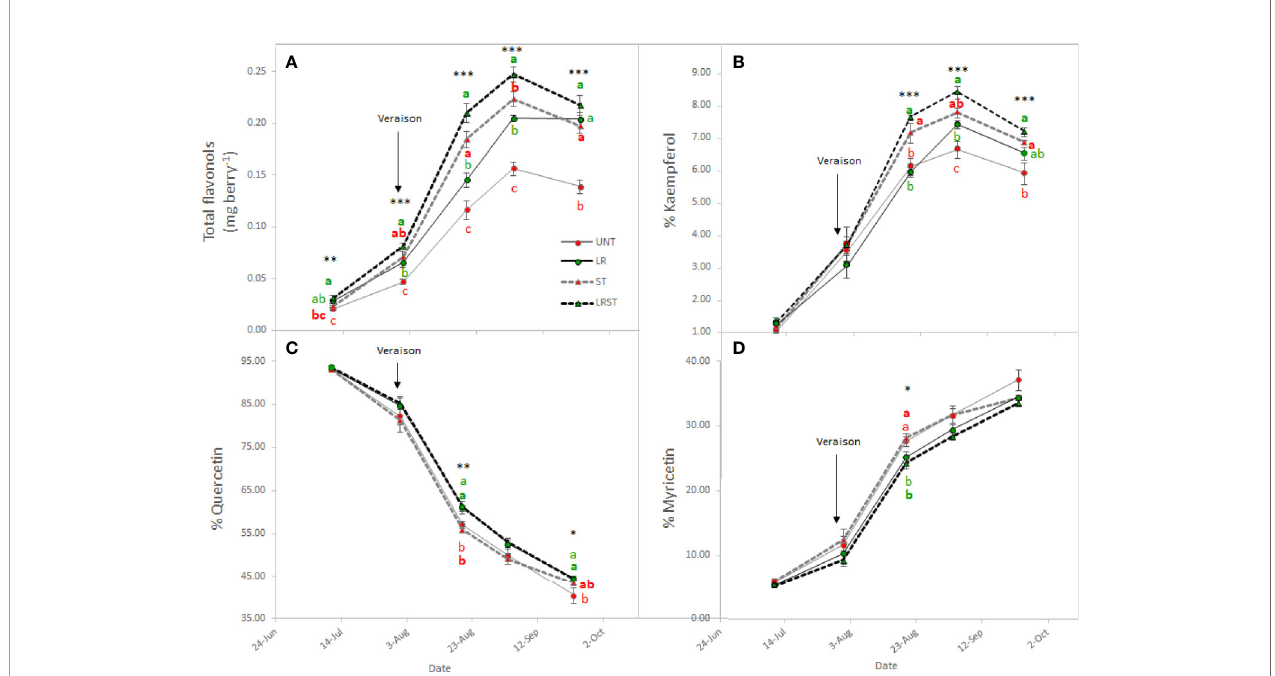
FIGURE 5 | Effect of canopy management practices (UNT: Untreated, LR: Leaf removal, ST: Shoot thinning and LRST: LR and ST combined) on berry skin fl avonol content (A) , percent Kaempferol (B) , percent Quercetin (C) , and percent Myricetin (D) during the growing season. Values represent means ± SE (n = 4). At each time point, different letters indicate signi fi cant differences ( p < 0.05) between canopy management practices according to the one-way ANOVA followed by Duncan's new multiple range test. *, **, and *** indicate signi fi cance at 5%, 1%, and 0.1% probability levels, respectively.